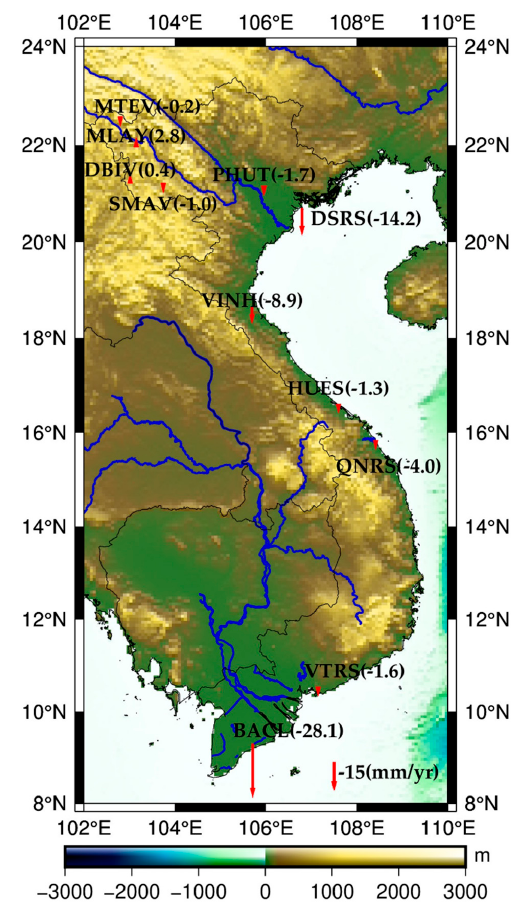
Figure 5. Vertical land motion rates from permanent GNSS